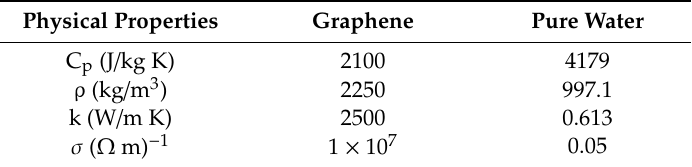
Table 1. Thermophysical properties of the water and graphene nanoparticles